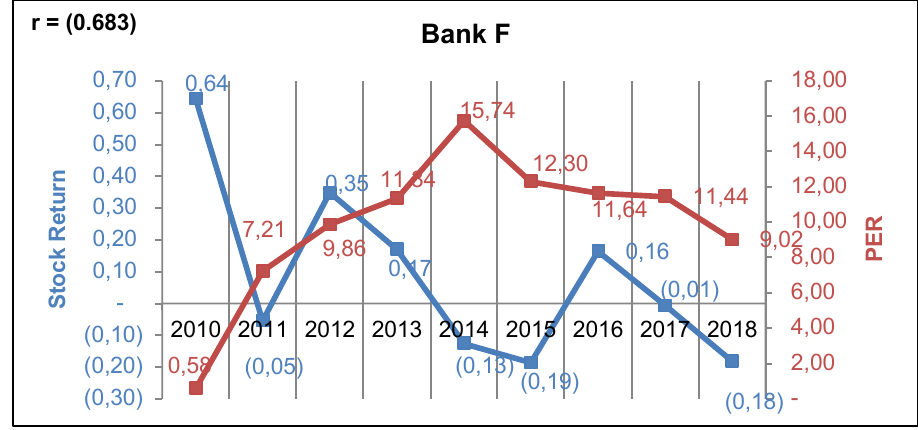
Figure 6: For Bank F Bank D, E and F have patterns that became similar from 2016 to 2018, and deviations where observed between the years 2013 to 2016.